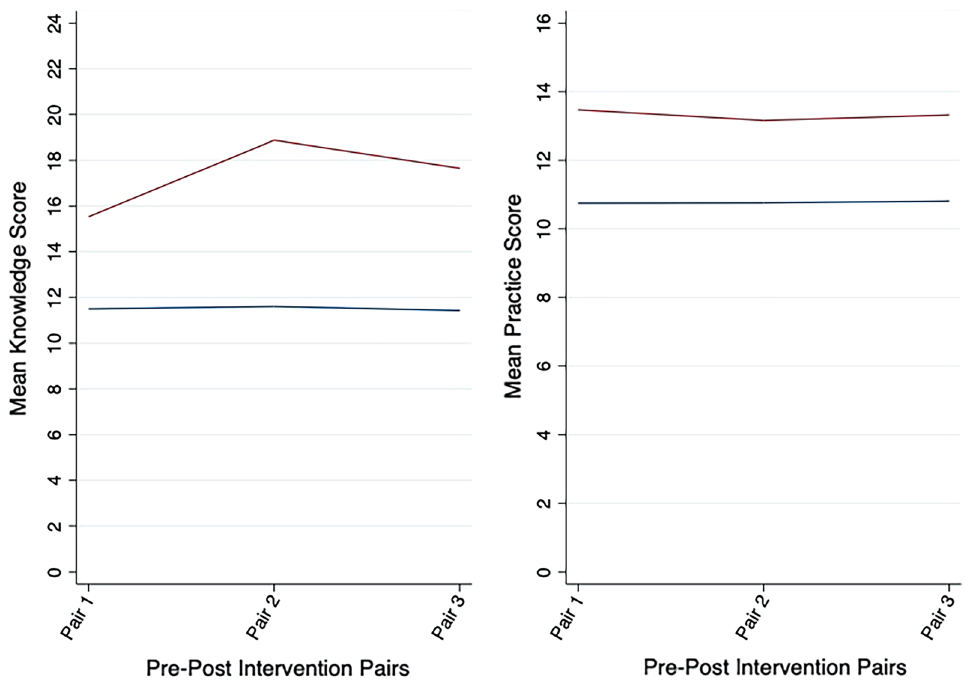
Figure 1. Shows the mean change in knowledge and practice score immediately after the intervention, two weeks after the intervention and 12 weeks after the intervention compared to the preintervention score where y-axis represents the knowledge and practice score in number and x-axis represents the pre-and-post intervention pairs. The blue line indicates the mean knowledge and practice score during preintervention period and red line indicates the mean knowledge and practice score at different points of intervention. Pair 1 = preintervention and immediate postintervention; pair 2 = preintervention and two weeks postintervention follow up; pair 3 = preintervention and 12 weeks post intervention follow up and p-value for each pair was obtained by paired t-test for both knowledge and practice scores which were highly significant with p <